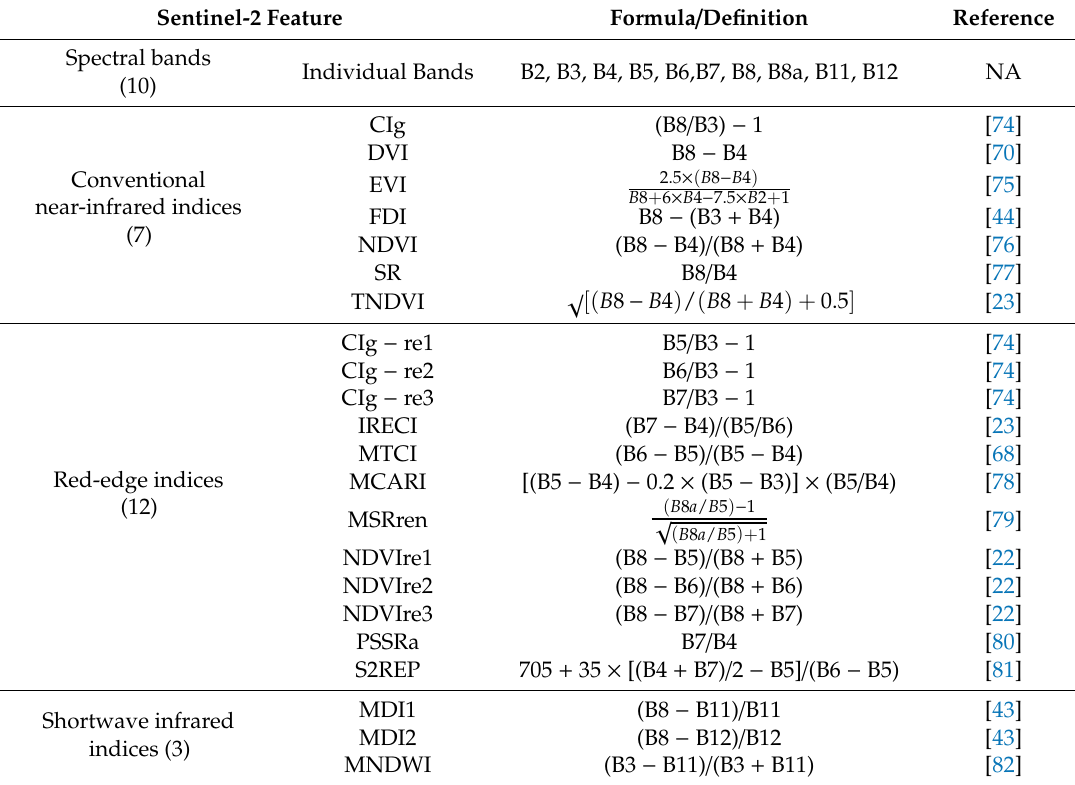
Table A2. The list of indices derived from Sentinel-2